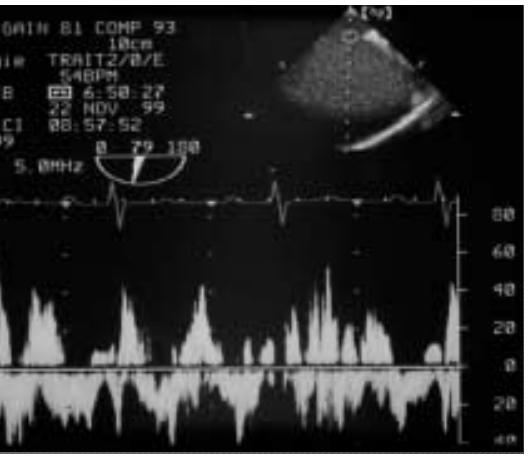
Post-operative transoesophageal colour Doppler echocardio- graphy, showing reduced degree of the tricuspid valve